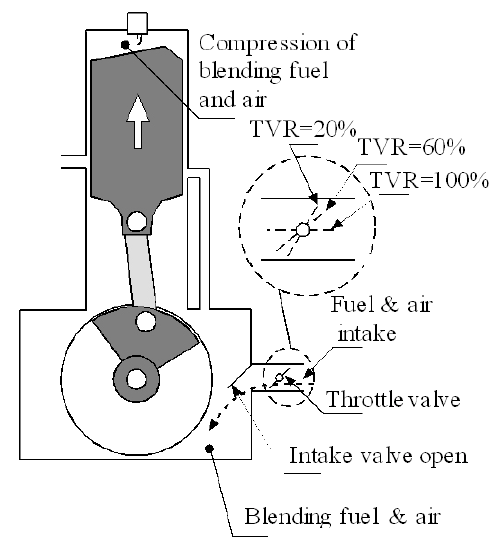
Figure 2. Typical single cylinder two stroke engine with valve adjuster.